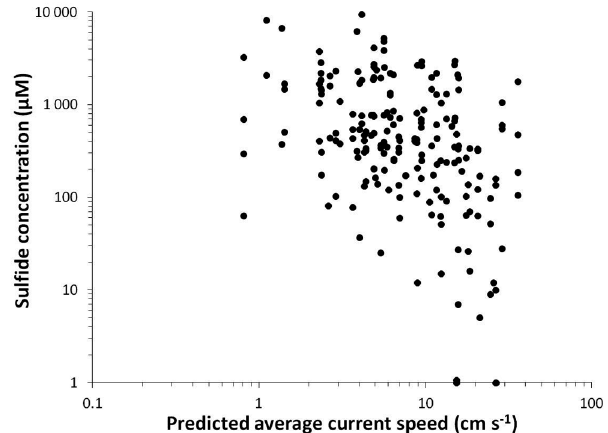
Fig. 2. Log-log relationship between salmon biomass and average sediment sulfide concentration in annual regulatory monitoring at salmon farms in SWNB, 2006 to 2009. Points on y -axis are fallowed farms (holding no fish at time